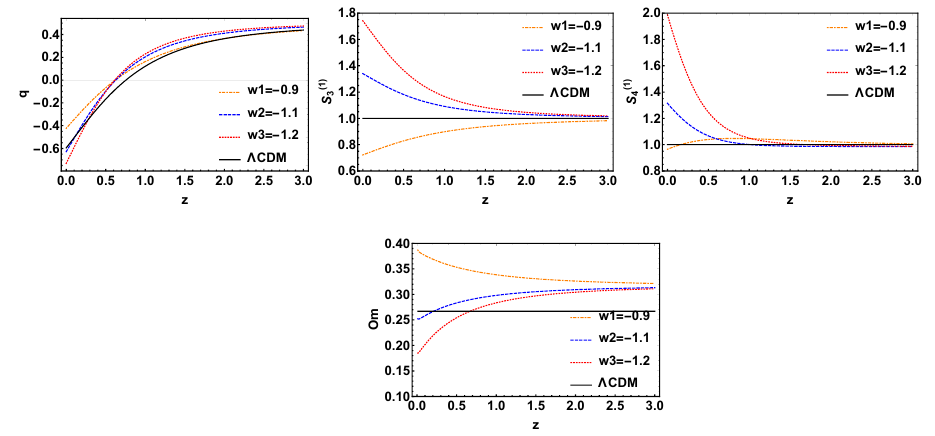
( 1 ) ( 1 ) , S and Om , respectively, versus red shift z for the 3 4